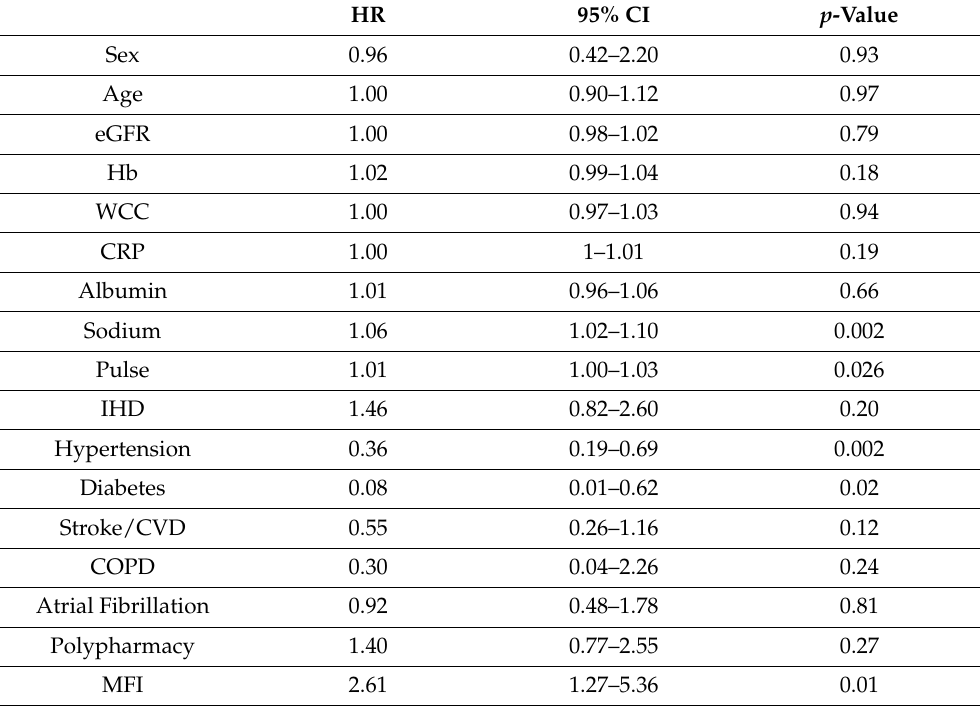
Table 5. Fully adjusted multivariate Cox proportional hazards model